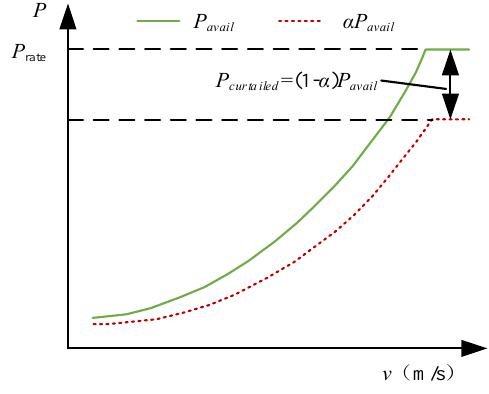
Figure 1. Diagram of the proportional curtailment strategy.